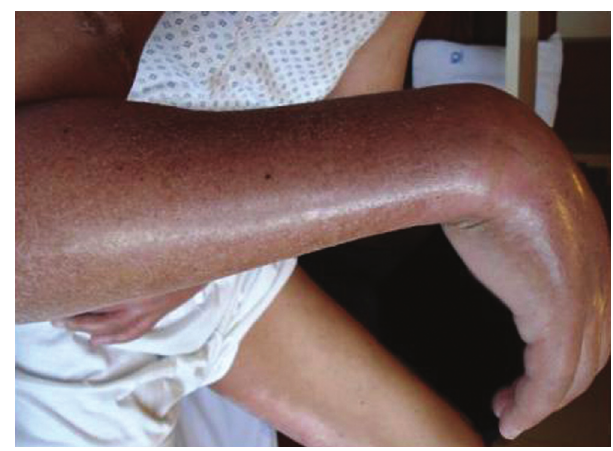
Figure 1 - Thickening and hardening of the skin of the right forearm